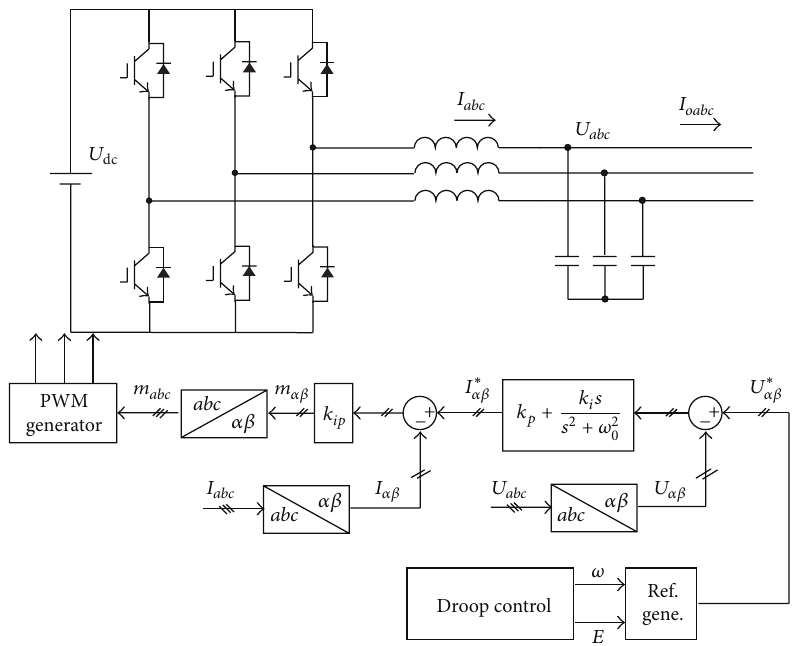
Figure 3: Block diagram of system loop control.